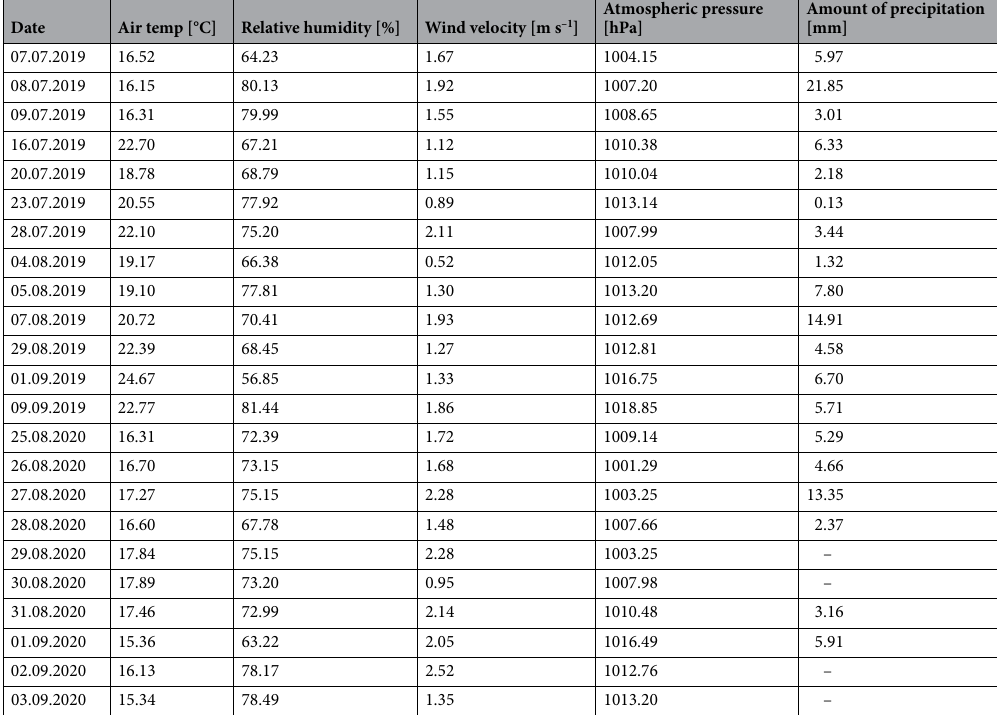
Table 1. The average of the meteorological parameters during the sampling days and the summed amount of precipitation. – means no rain